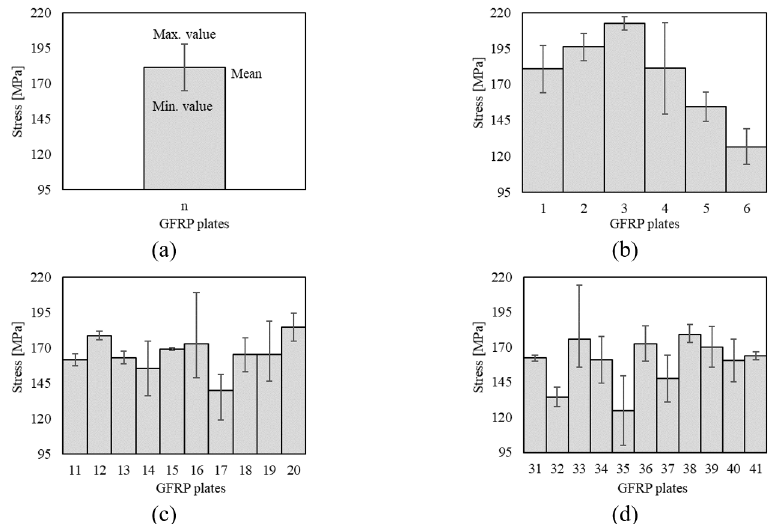
Figure 10. Ultimate tensile stress: (a) description of the constituent parts of the graphics; (b) Group 01; (c) Group 02; (d) Group